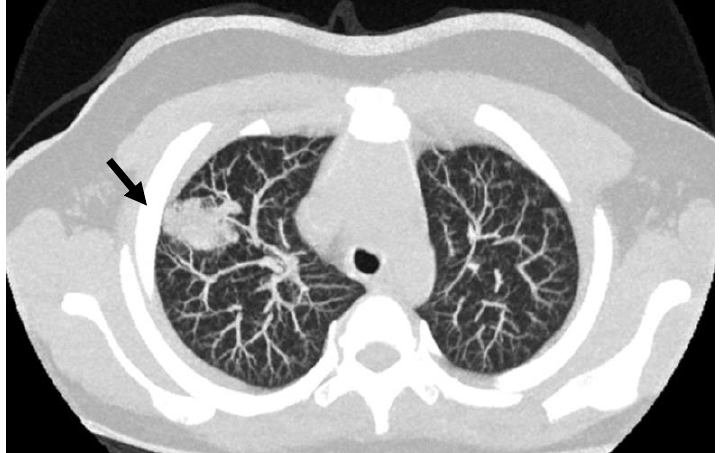
Figure 2. Lung CT scan in an 8 yrs old child; the arrow points to the presence of PAVM in the lung right upper lobe. right upper